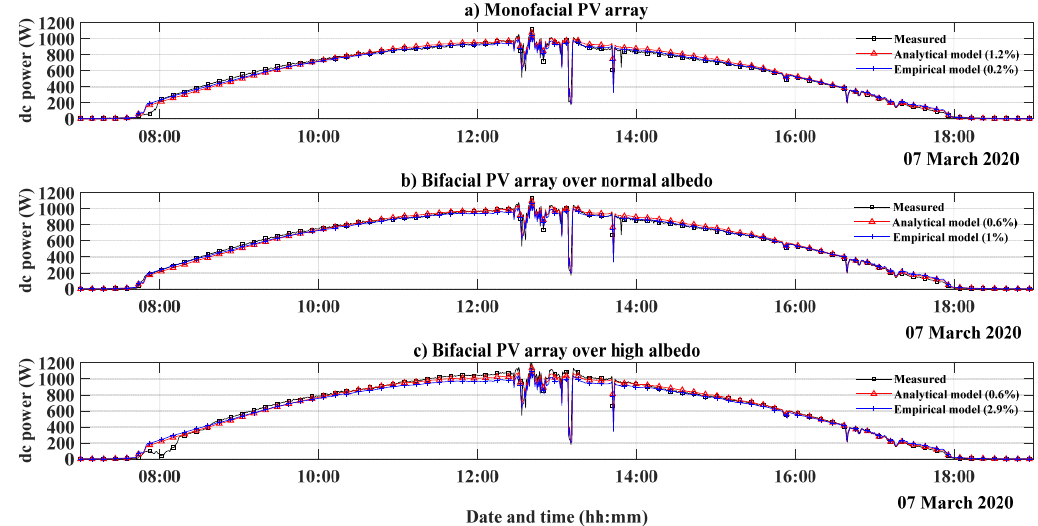
Figure 7. Comparison between the measured and simulated power output of the PV arrays under a clear sky. ( a ) Measured and simulated DC power of the monofacial PV array. ( b ) Measured and simulated DC power of the bifacial PV array with normal albedo. ( c ) Measured and simulated DC power of the bifacial PV array under high albedo.